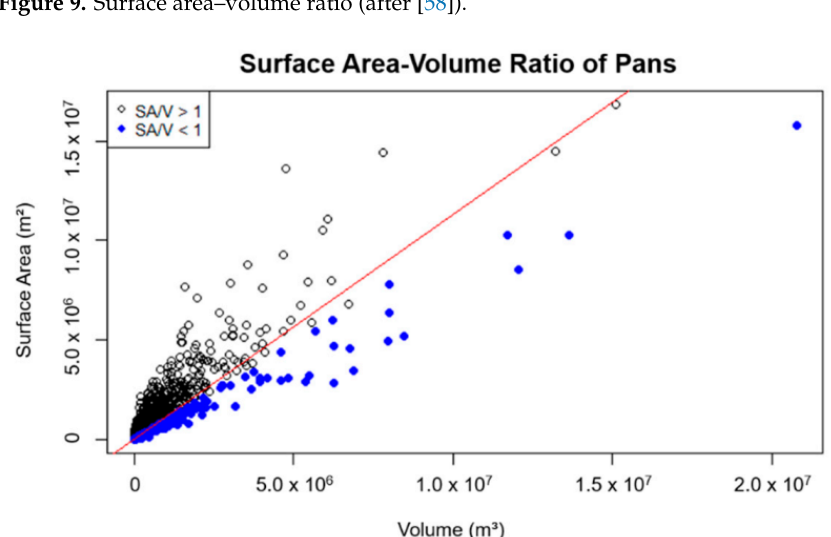
Figure 10. Surface area–volume ratio (SA/V) of all pans. Blue dots indicate the most suitable pans for